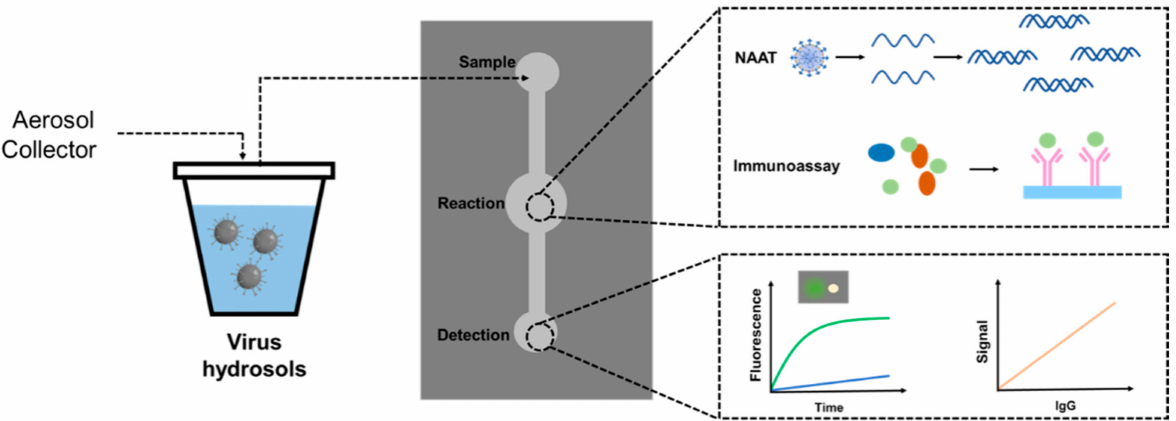
Figure 3. Detection mechanisms of microfluidic devices for airborne virus. NAAT: Nucleic acid amplification